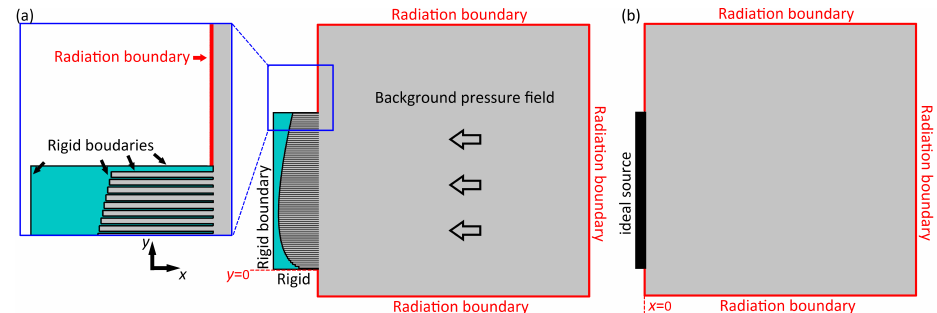
Figure 2. Sketch of the numerical setup for the simulations with ( a ) the metastructure and ( b ) the ideal source. Radiation boundaries (red solid lines) are applied to the outer boundaries of the computation domain, whose size is 1.8 m × 1.8 m. ( a ) Boundaries of the metastructure are set to be rigid (black solid lines). Background pressure field (gray) is used to generate an incident plane wave propagating along − x direction. Inset: zoom-in plot in the region marked by the blue box. ( b ) Black solid rectangular indicates the ideal source to generate the ideal bending field